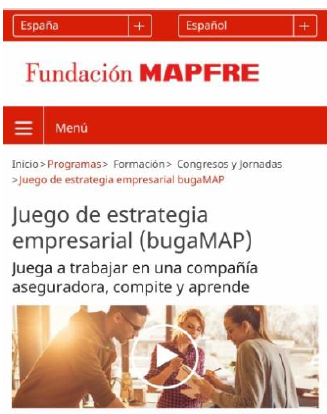
Figure 1. Online presentation of BugaMAP game. Source: Fundación MAPFRE website [29].